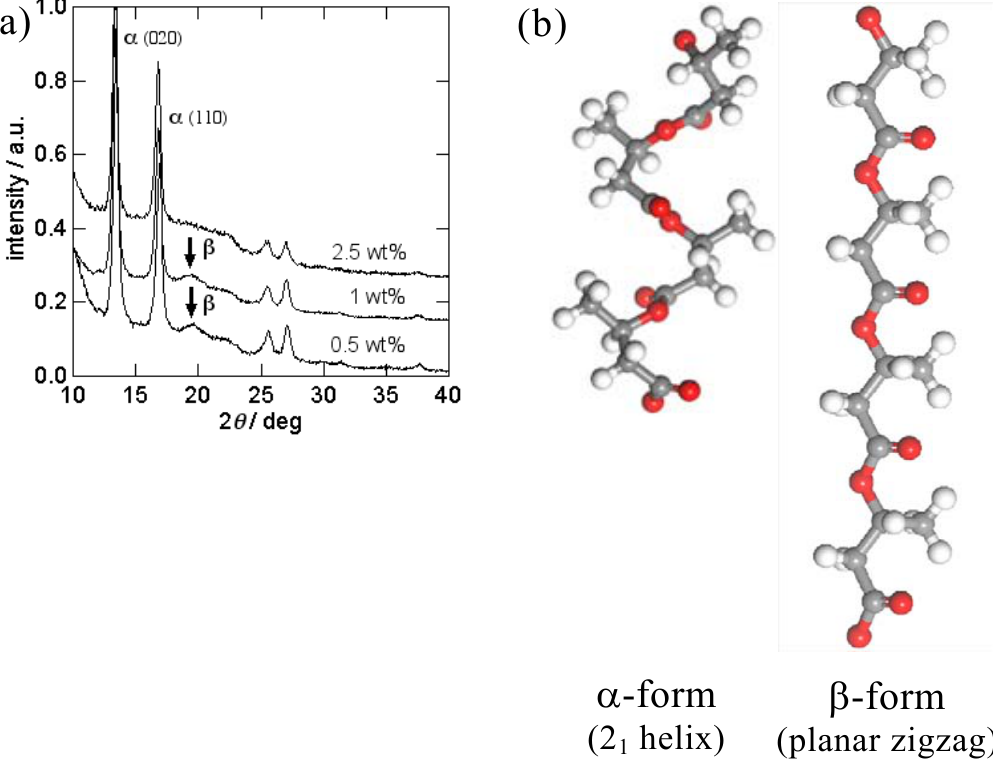
Figure 3. (a) WAXD profiles of as-spun P(3HB) nanofiber mats and (b) molecular conformations of α -and β -form of P(3HB) [52].